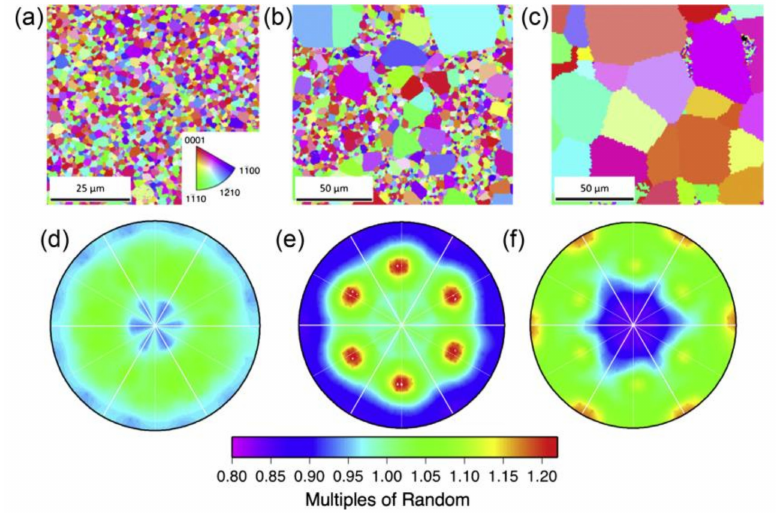
Figure 12. ( a–c ) Orientation maps illustrating the microstructures and ( d–f ) grain boundary plane distributions for 450 ppm Y-doped alumina. ( a,d ) 1450 ◦ C, ( b,e ) 1500 ◦ C, ( c,f ) 1600 ◦ C. The grain boundary plane distributions are plotted in stereographic projection with the [0001] direction normal to the page and the [1120]reaction horizontal [45,61]. (reprinted with the permission from